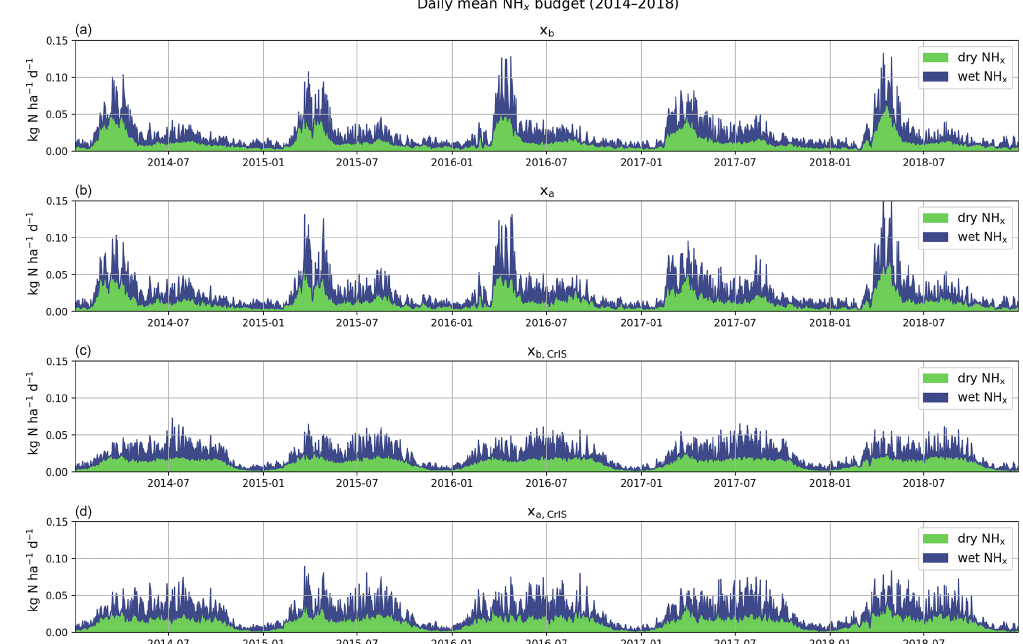
Figure 11. Time series of the average amounts of dry (green) and wet (blue) NH x deposition in the different model runs. Panels (a) and (b) represent the default background ( x b ) and analysis ( x a ) run, and panels (c) and (d) represent the background ( x b , CrIS ) and analysis ( x a , CrIS ) run with the CrIS-based NH 3 time